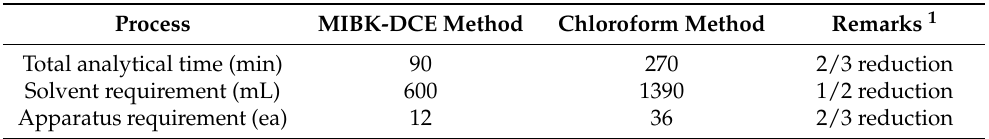
Table 10. Comparison of scale of operation between MIBK-DCE method and chloroform method in SDS analysis ( n = 12).